Question: Briefly state, in one sentence, what is plotted here.
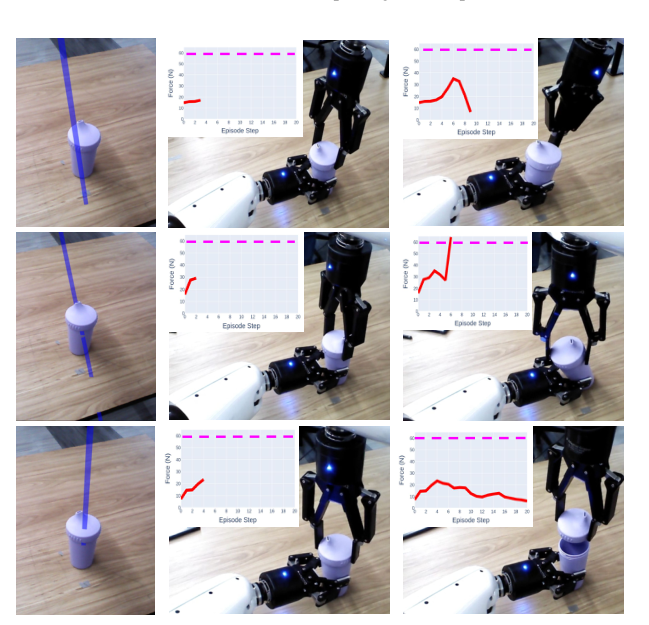
Answer: Reward Intuition. Each row shows the screw axis and the snapshots of the corresponding episode to showcase the use of the reward components – Grasp lost (first row), FT sensor reaching the threshold (second row). Each snapshot has the corresponding FT sensor reading until that timestep. The pink line shows the FT threshold. The last row shows an example of a success with the corresponding FT sensor readings.